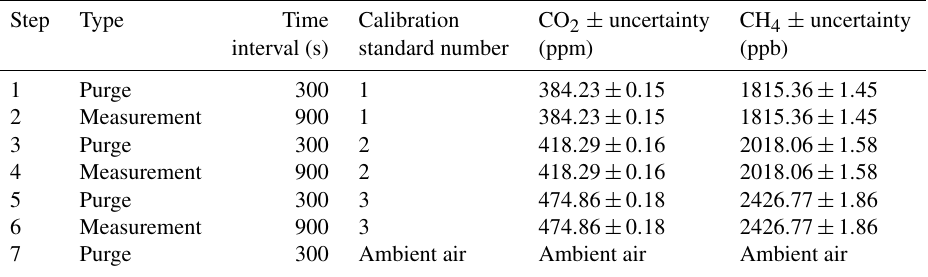
Table 2. Details of the weekly auto-calibration sequence (interval 169h) and reference gases. The reference gases were calibrated by the Swiss Federal Laboratories for Materials Testing and Research (World Calibration Centre WCC-EMPA, Dübendorf, Switzerland) using a Picarro 1301 CRDS. Calibration scales (NOAA/ ESRL): WMO-CH 4 -X2004 for methane and WMO-CO 2 -X2007 for carbon dioxide. The measurement uncertainties correspond to the standard deviation multiplied by a coverage factor k = 2, which provides a level of confidence of approximately 95%. Step